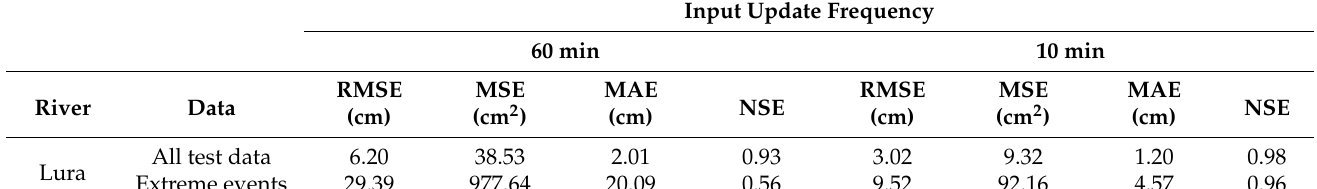
Table 7. Comparison of multivariable LSTM performance with 60- and 10-min input update frequency for the entire test dataset and flood events only. Rain gauges scenario, Lura River.